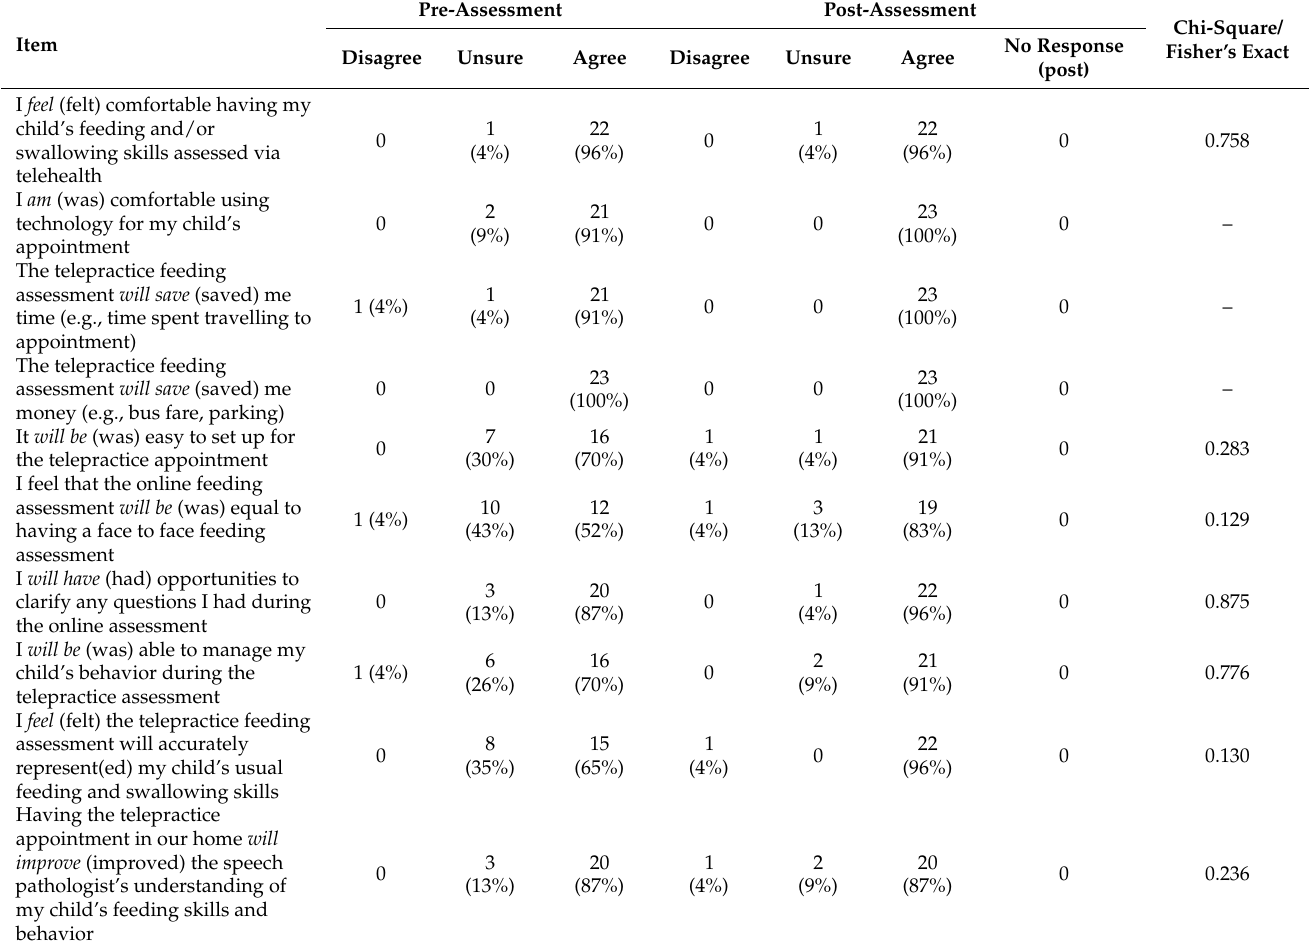
Table 6. Parents’ pre-post perceptions of telepractice assessments using the Telepractice for Feeding Questionnaire ( n = 23)